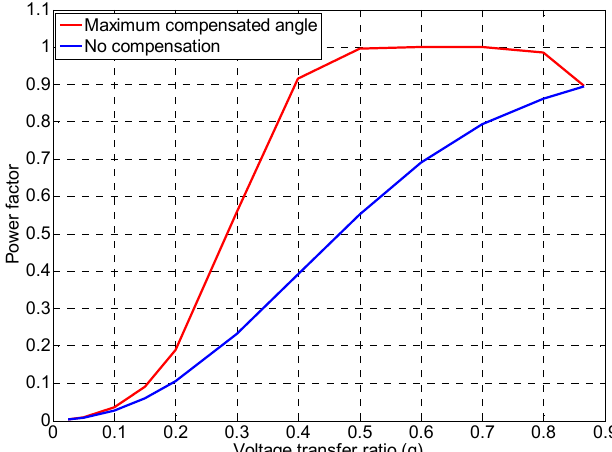
Figure 18. Comparison between IPF under no compensation and maximum compensated angle conditions at 0.375 Q = .